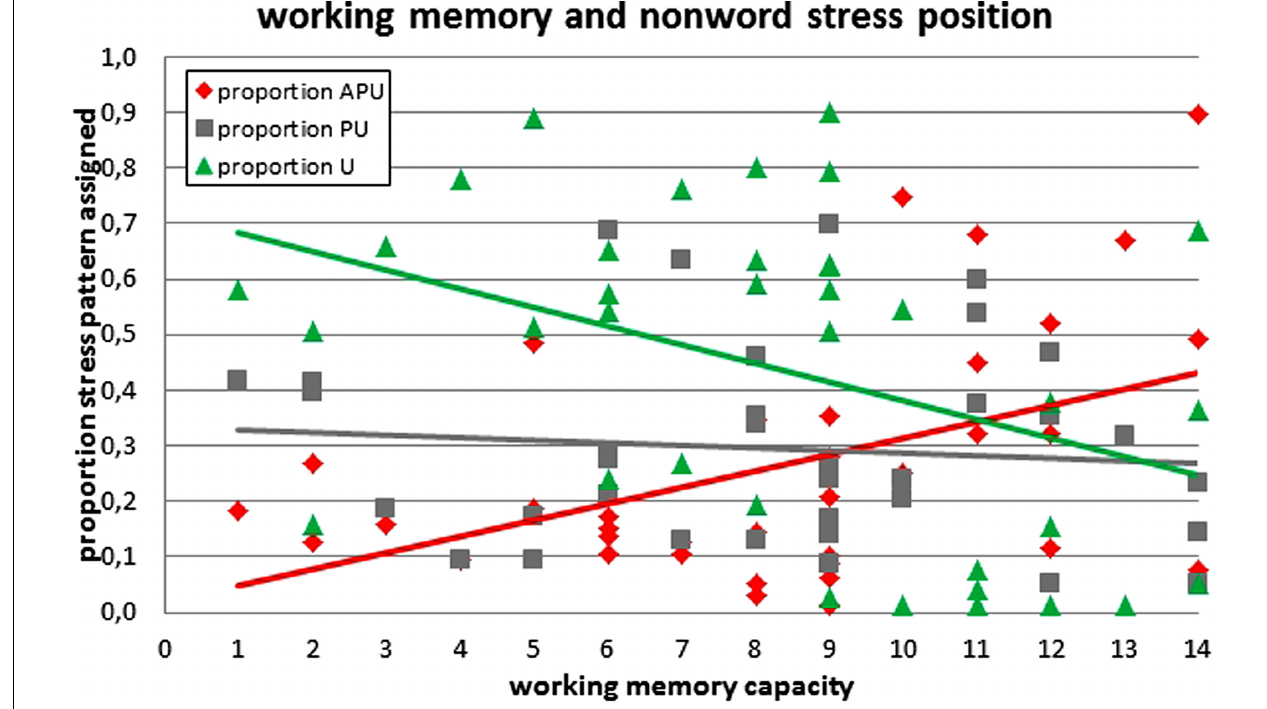
FIGURE 1 |Assignment of main stress in non-word reading as a function of individual working memory capacity. (Note that we plotted linear functions in this graph, while we used a non-parametric procedure in actual analyses, which does not assume a linear function.)